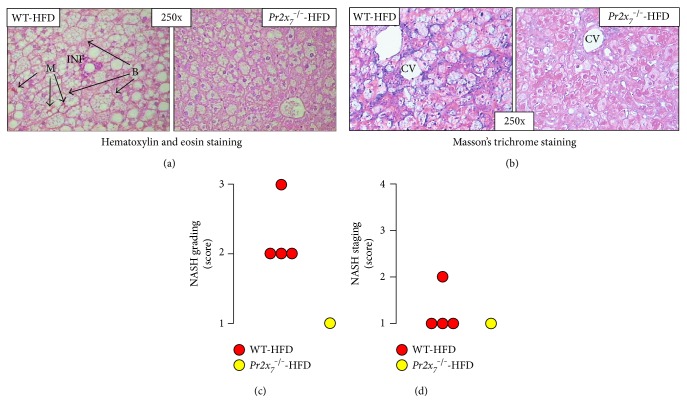
NASH grading and staging. Hematoxylin and eosin ((a); original magnification 250x) and Masson's trichrome ((c); original magnification 250x) staining of liver sections from representative animals; and NASH grading (c) and staging (d) in the HFD-fed WT (n = 4) and Pr2x7−/− (n = 1) mice fulfilling NASH criteria. P = portal space; CV = centrolobular vein; B = ballooning degeneration; M = Mallory's body; INF = inflammation. NASH = nonalcoholic steatohepatitis; HFD = high-fat diet; WT = wild type; Pr2x7−/− = knockout for purinergic receptor 2X7 gene.